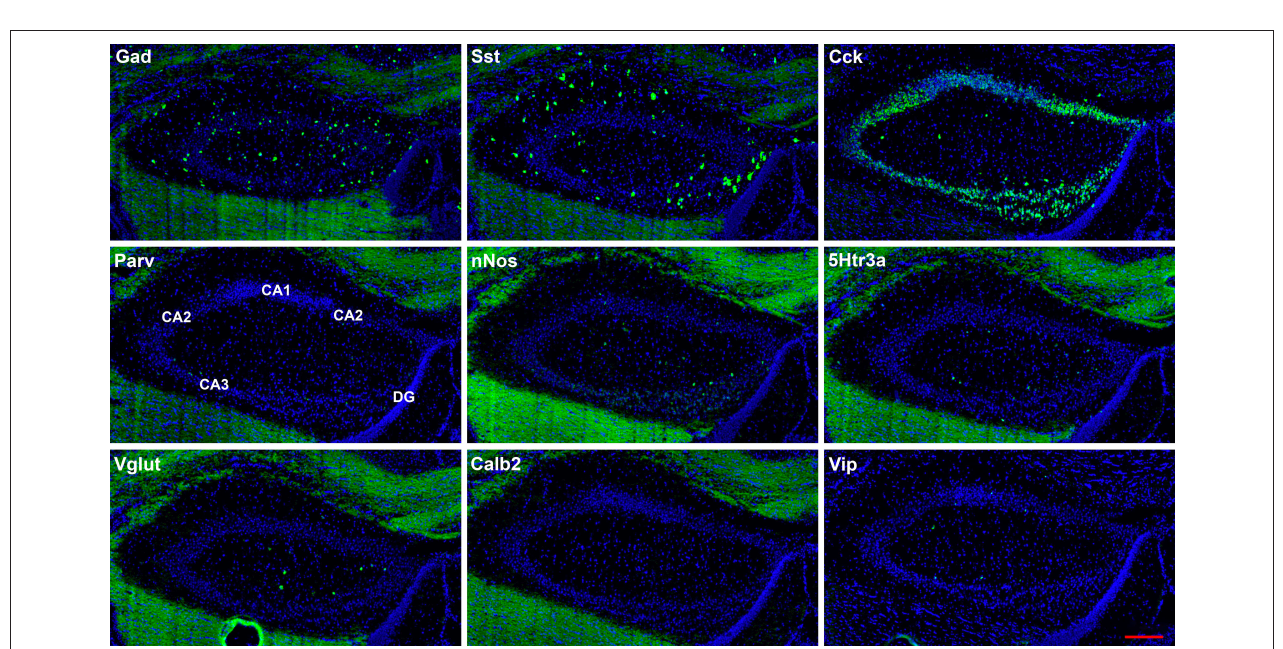
FIGURE 3 | Representative low-magnification photomicrographs of very anterior dorsal hippocampus at 1.1mm behind the bregma showing expression of nine interneuron types. White matter tracts show some autofluorescence (green) in some panels. The bar equals 200 µ m for all panels.